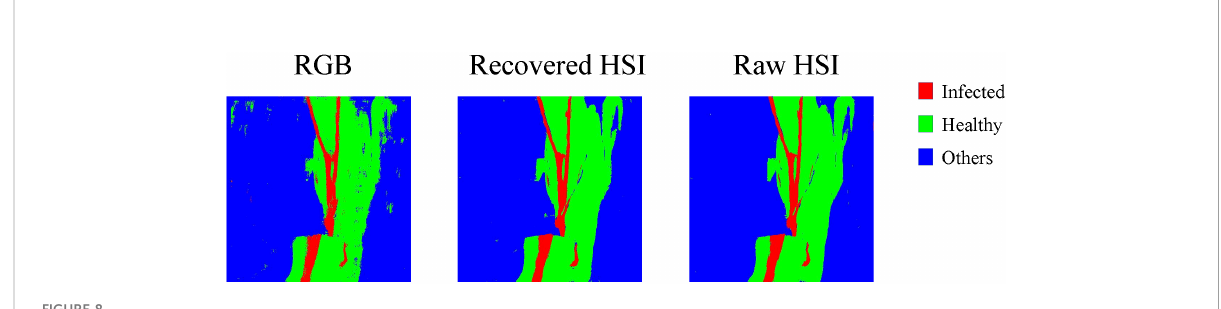
FIGURE 8 Visual comparison of disease detection using RGB image, recovered HSI. and raw HSI.